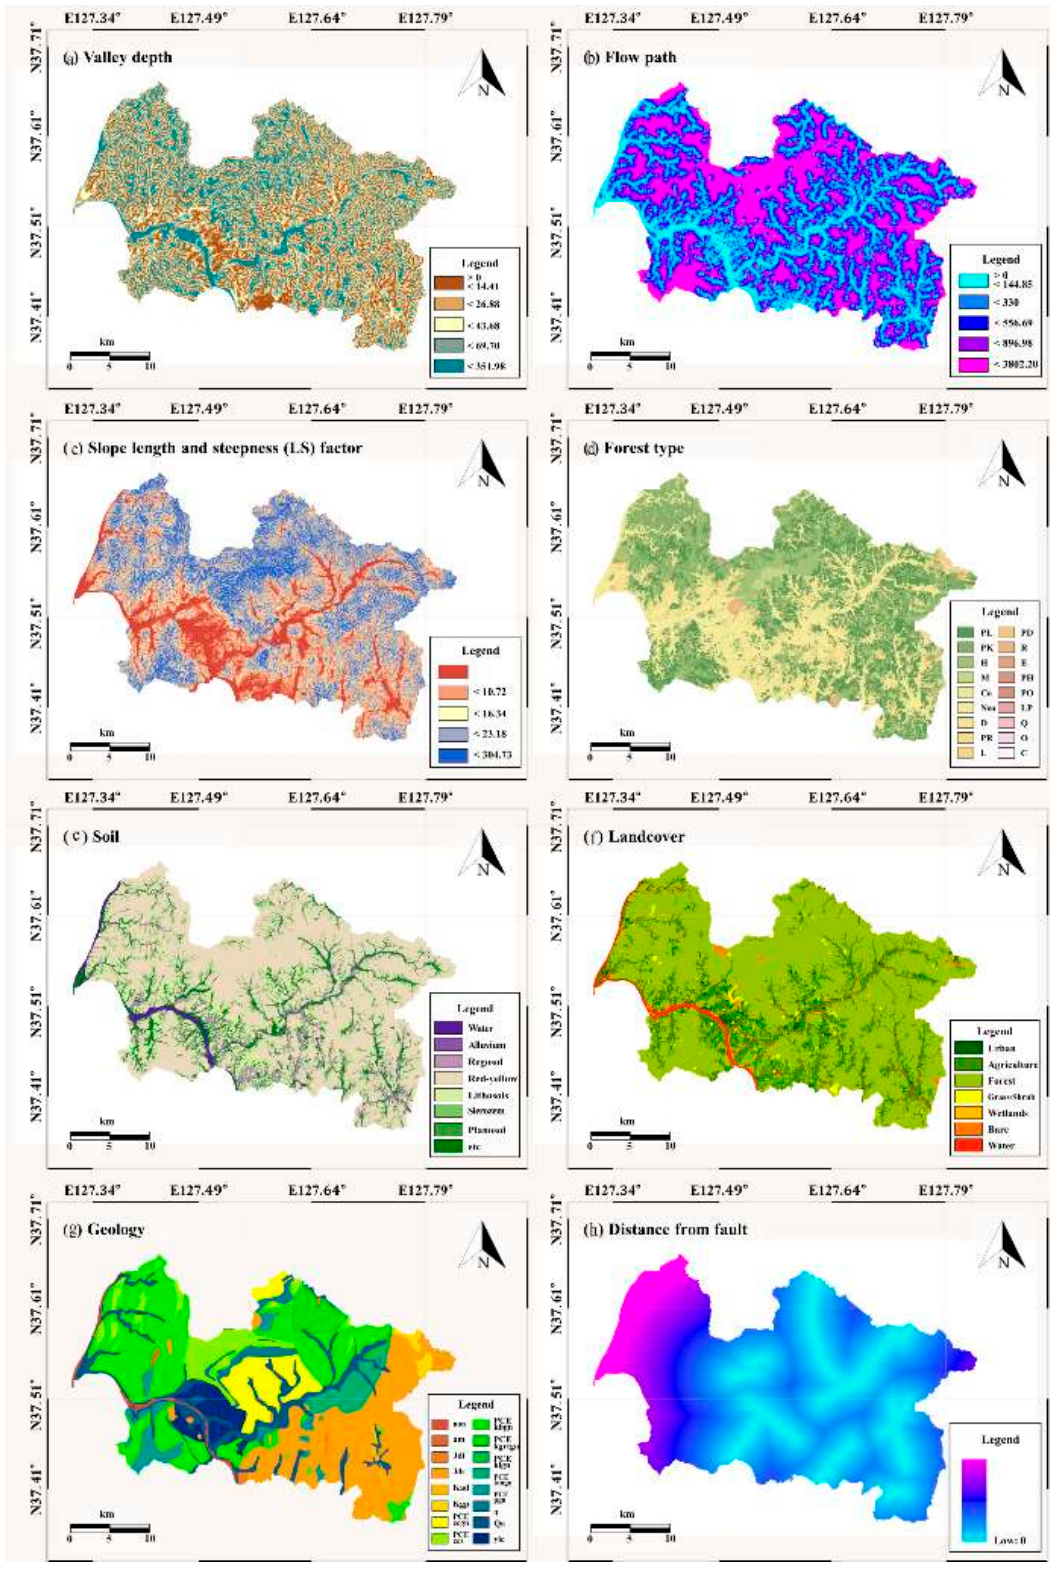
Figure 4. Groundwater conditioning factors II: ( a ) Valley depth, ( b ) Flow path, ( c ) Slope length and steepness (LS) factor, ( d ) Forest type, ( e ) Soil, ( f ) Land cover, ( g ) Geology and ( h ) Distance from